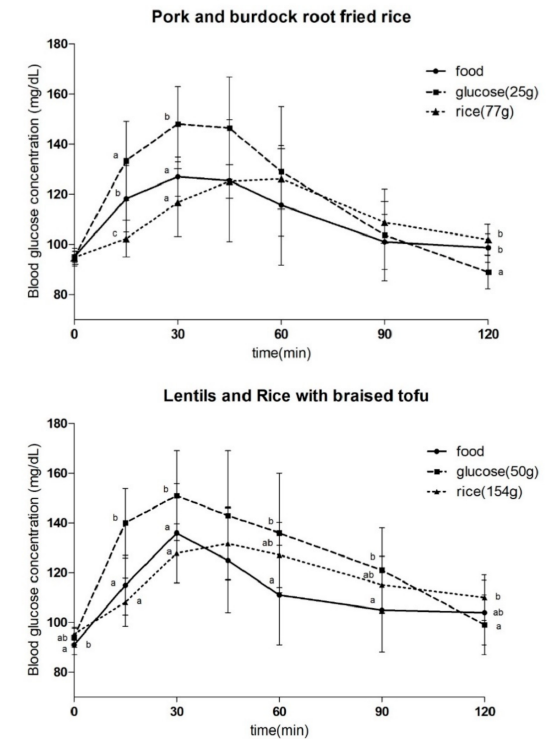
Figure 1. Incremental blood glucose profile for 120 min following the consumption of the selected foods and glucose and rice comprising 25. and 50 g of carbohydrates. Values are presented as mean ± standard deviation. Significant differences by analysis of variance and Duncan’s post-hoc test between glucose levels at certain time points are indicated with different letters ( p <